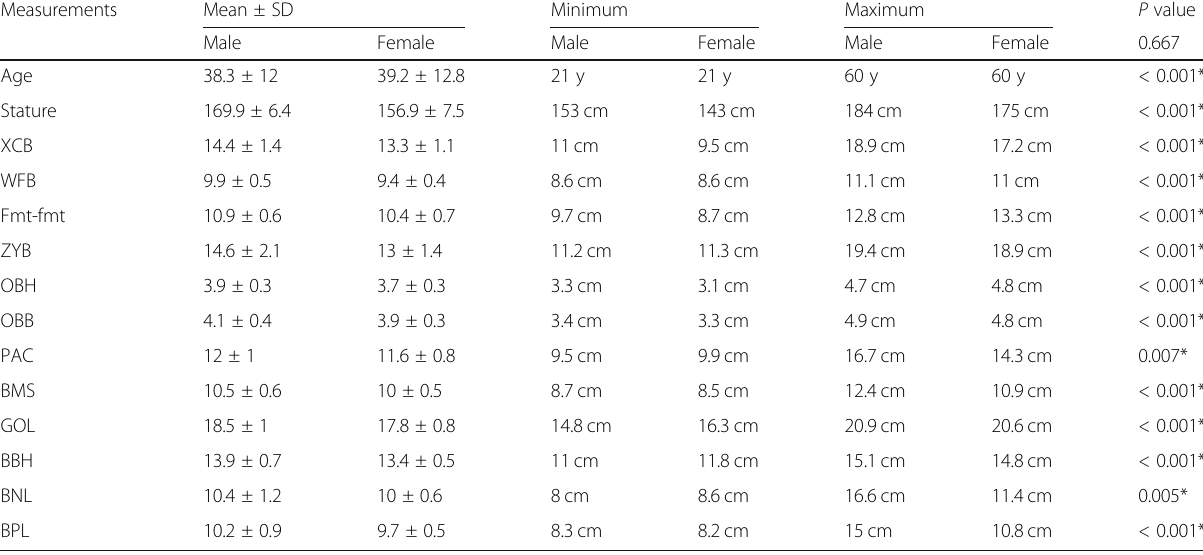
Table 2 Descriptive statistics and independent sample t test of stature and skull measurements in pooled cases ( n = 150 cases), males ( n = 80 cases), and females ( n = 70 cases) Measurements